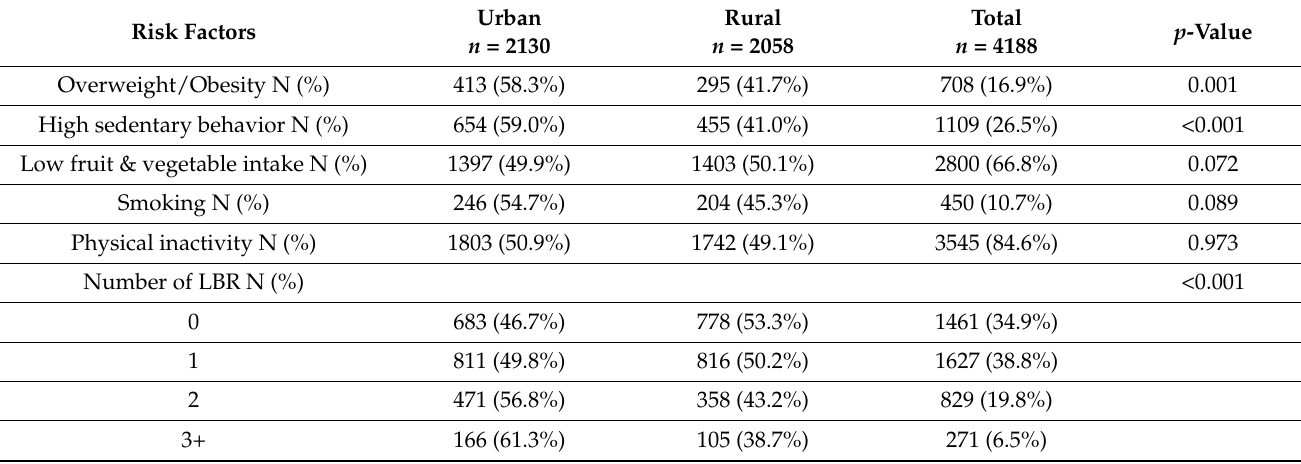
Table 2. Prevalence of lifestyle risk factors of Algerian adolescents aged 11–16